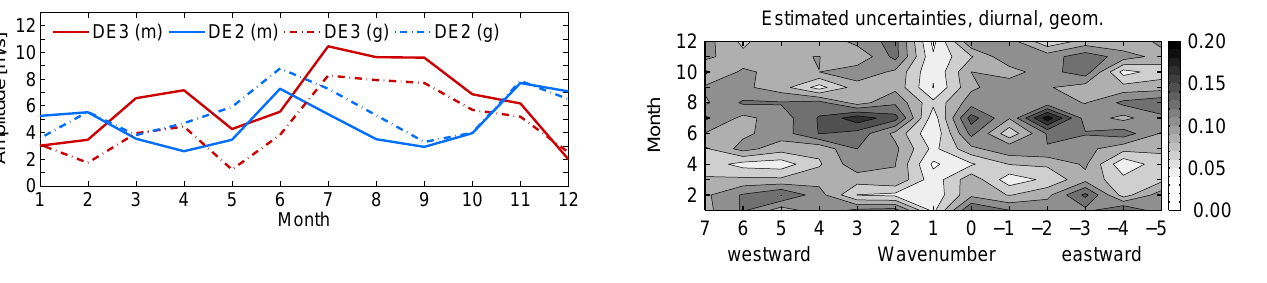
Fig. 6. Estimated formal uncertainties [m/s] of the CHAMP tidal analysis for the diurnal tidal spectrum along the geomagnetic equa- tor. The largest uncertainties are observed during June Solstice when the upper thermospheric density has its